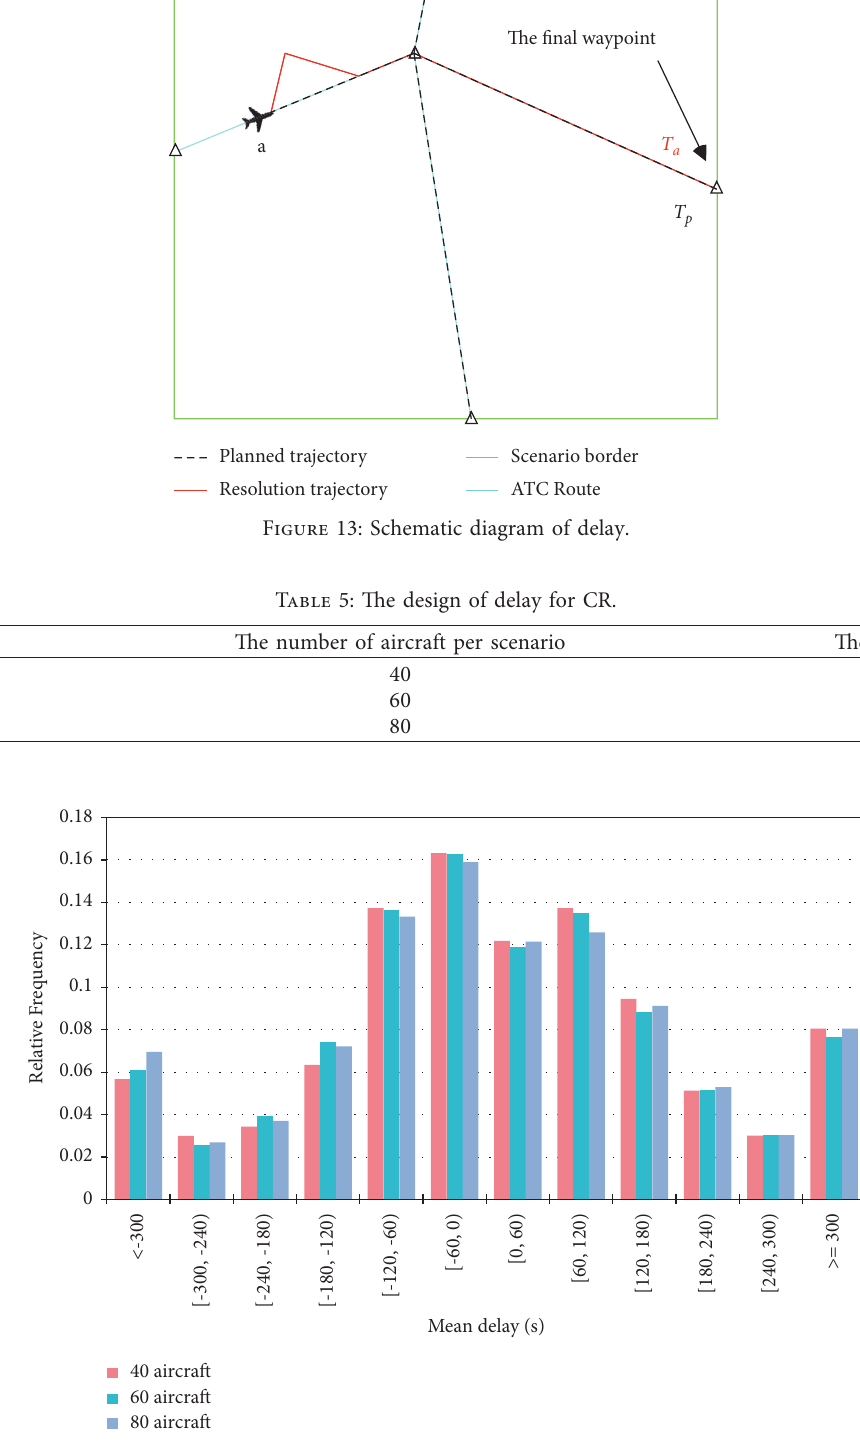
Figure 14: The distribution of delays: “40 aircraft” means that there are 40 aircraft in a